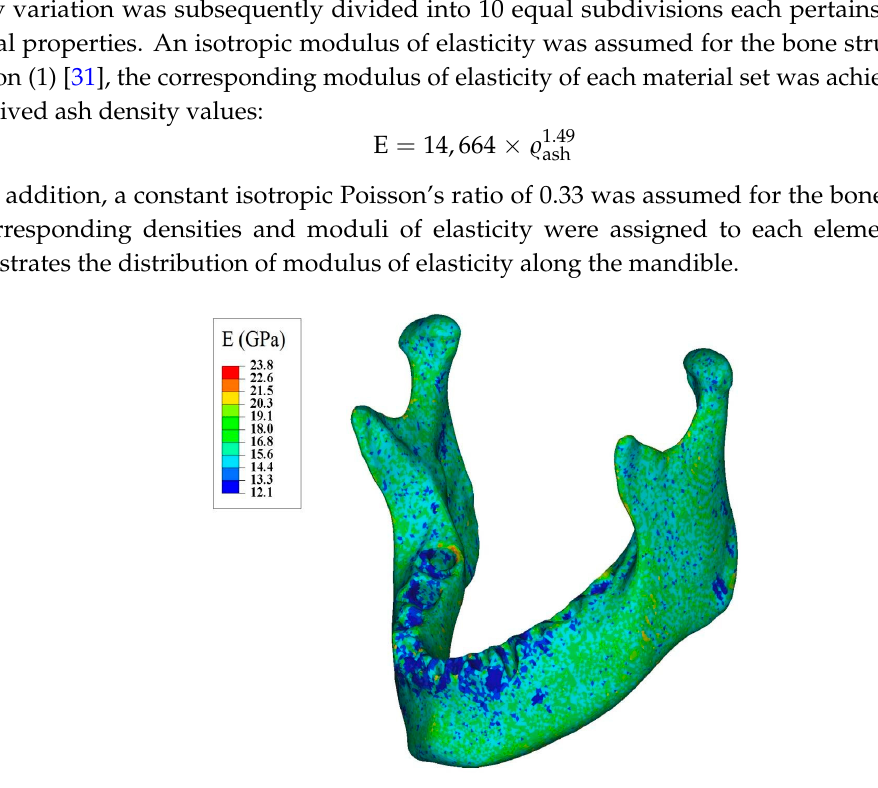
Figure 4. The mesh convergence study was done to define the optimized number of elements for each component. The vertical axis shows the maximum von Mises stress on each component relative to the maximum von Mises stress on the same component with the highest number of elements.